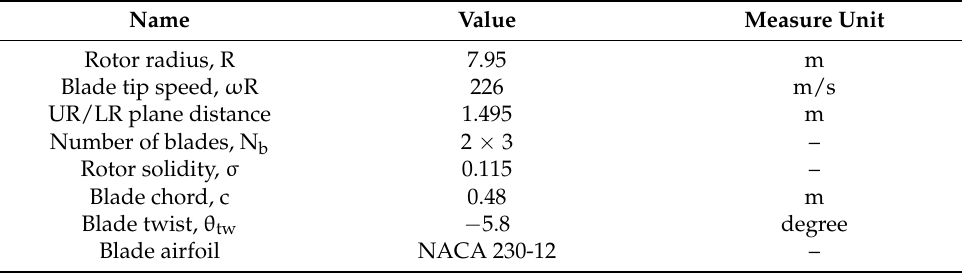
Table 1. Characteristics of the coaxial rotor under study